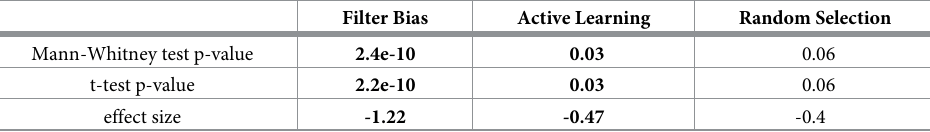
Table 2. Results of the Mann-Whitney U test and t-test comparing the size of the class-1-blind spot for the three forms of iterated algorithmic bias. Bold means significance at p < 0.05. The effect size is ( BlindSpot | t = 0 − Blind- Spot | t = 200 )/ standard . dev . The negative effect size shows that filter bias increases the class-1-blind spot size. For active learning bias, the p-value indicates the significance, however the effect size is small. Random selection has no signifi- cant effect.